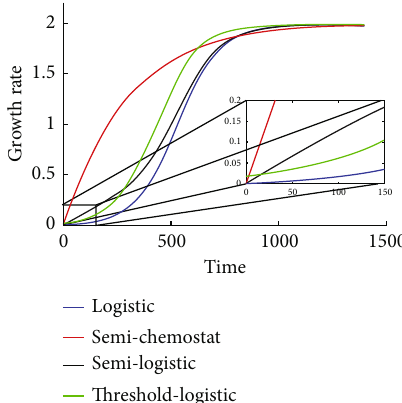
Figure 1: Graphs for the semichemostat, logistic, threshold- logistic, and semilogistic curves, used in the growth rate models for the